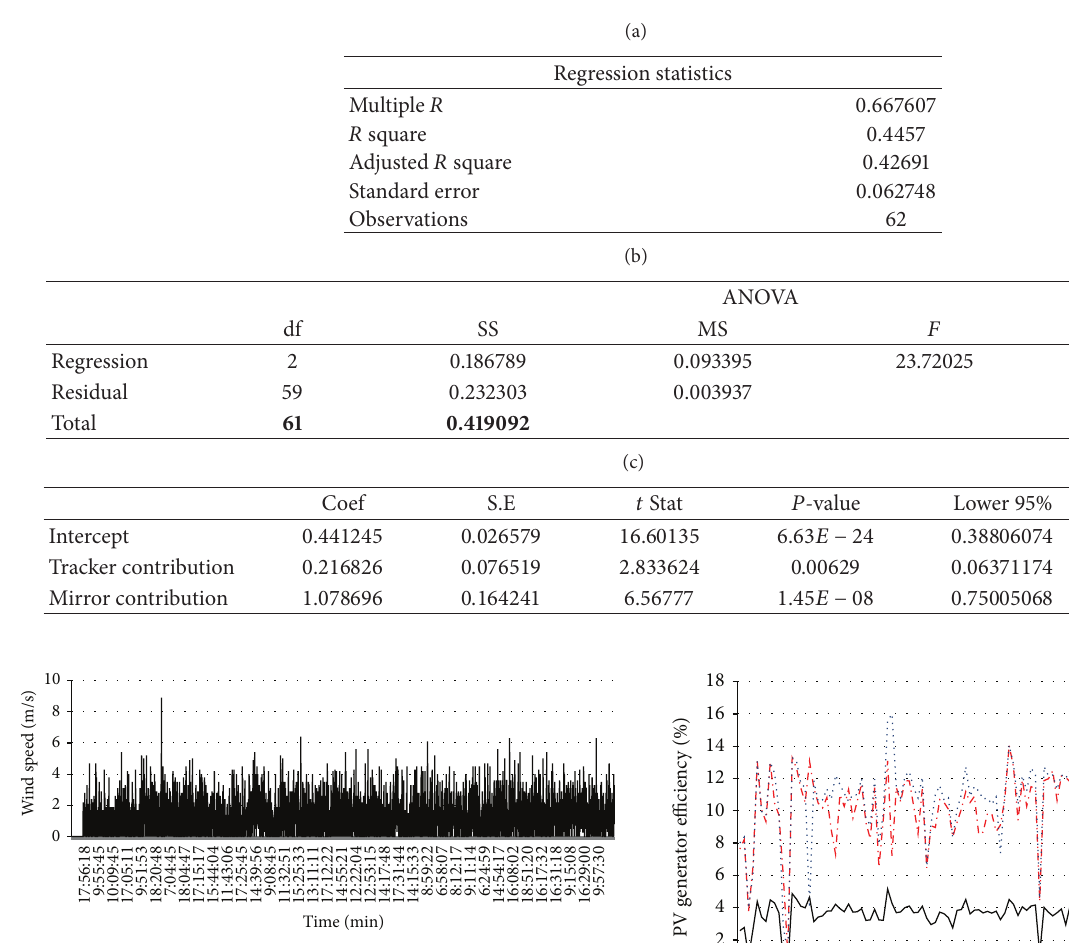
Figure 5: Wind profile throughout the monitoring period.